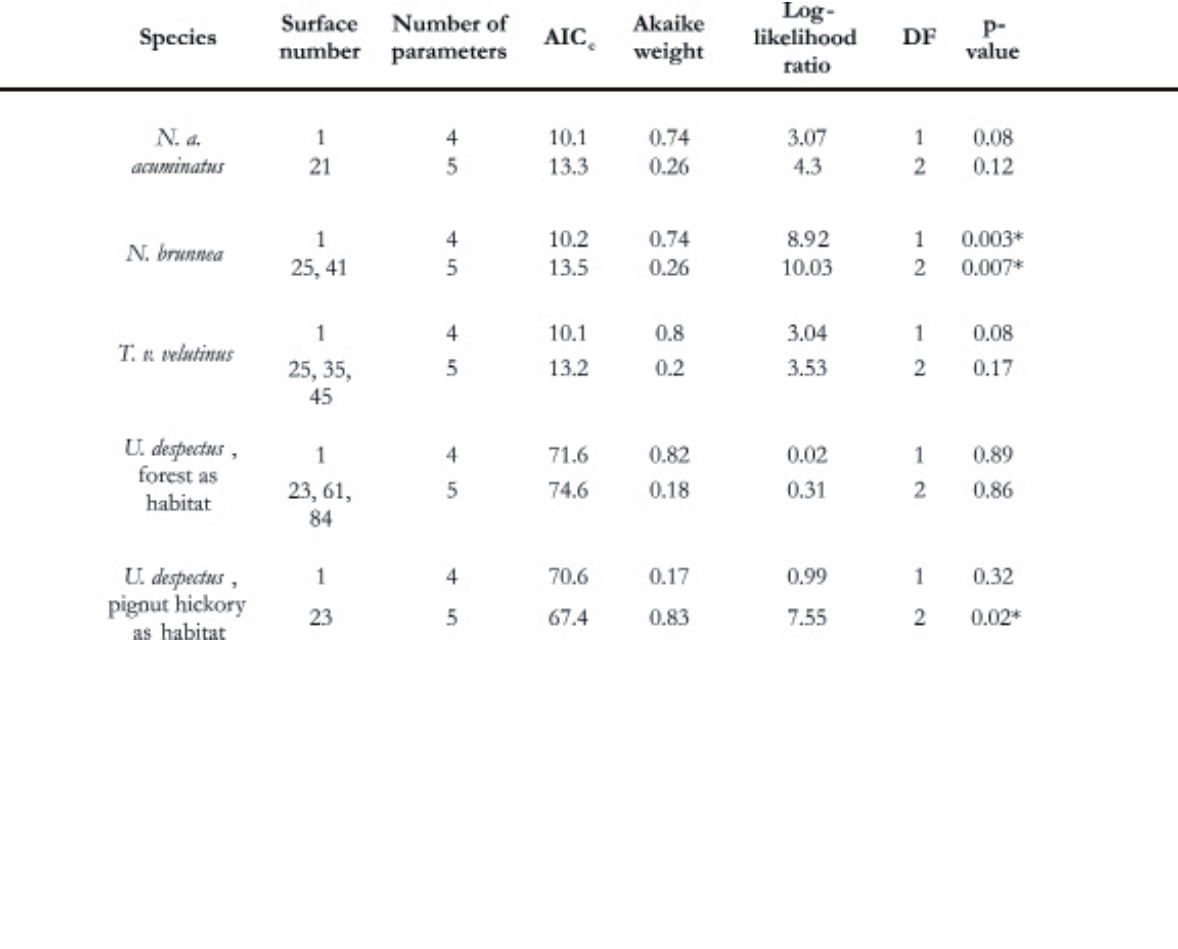
Table 5. Goodness of fit and model significance statistics for each species for the Euclidean distance surface (1) and the best-fitting cost surface(s). Significant log-likelihood ratios are marked with an asterisk